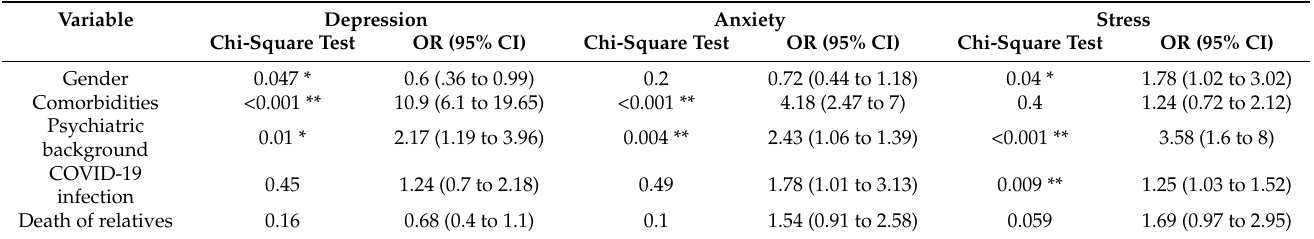
Table 1. Contingency table, factors associated with depression, anxiety, and/or